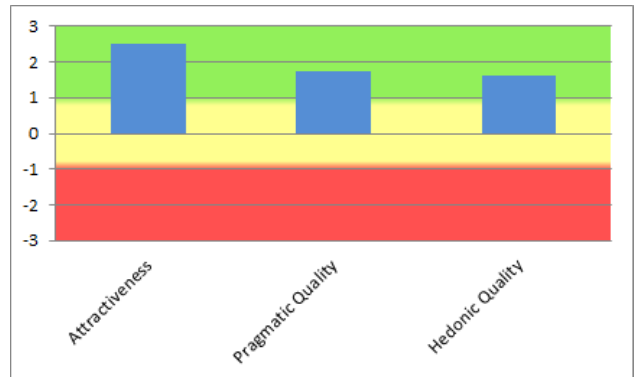
Fig. 6. TUEQ group results.